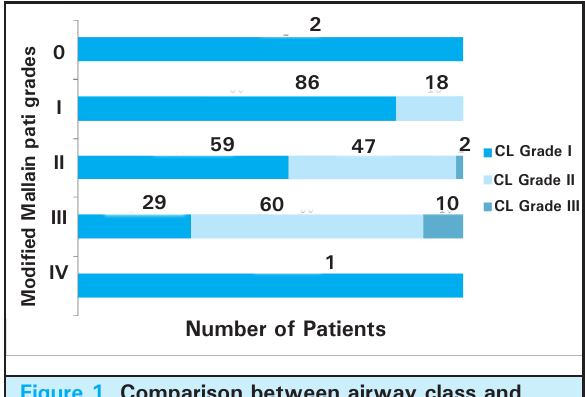
Figure 1. Comparison between airway class and laryngoscopic